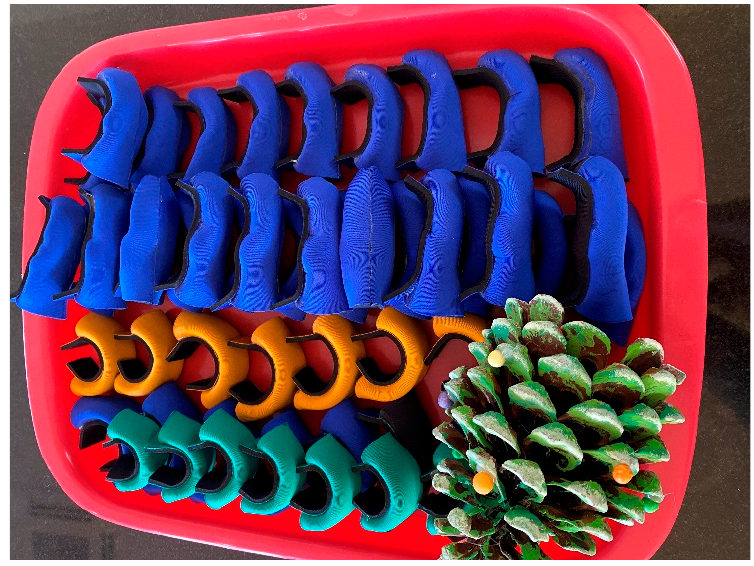
Figure 5. ETDNO with tubes at di ff erent positions.